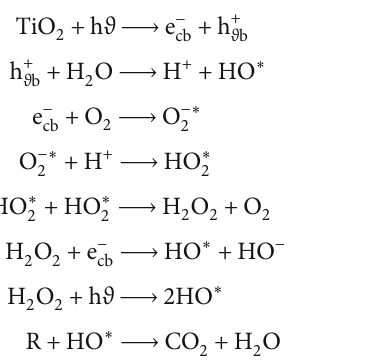
NPs for MB dye solution, (b) C/C 2 2